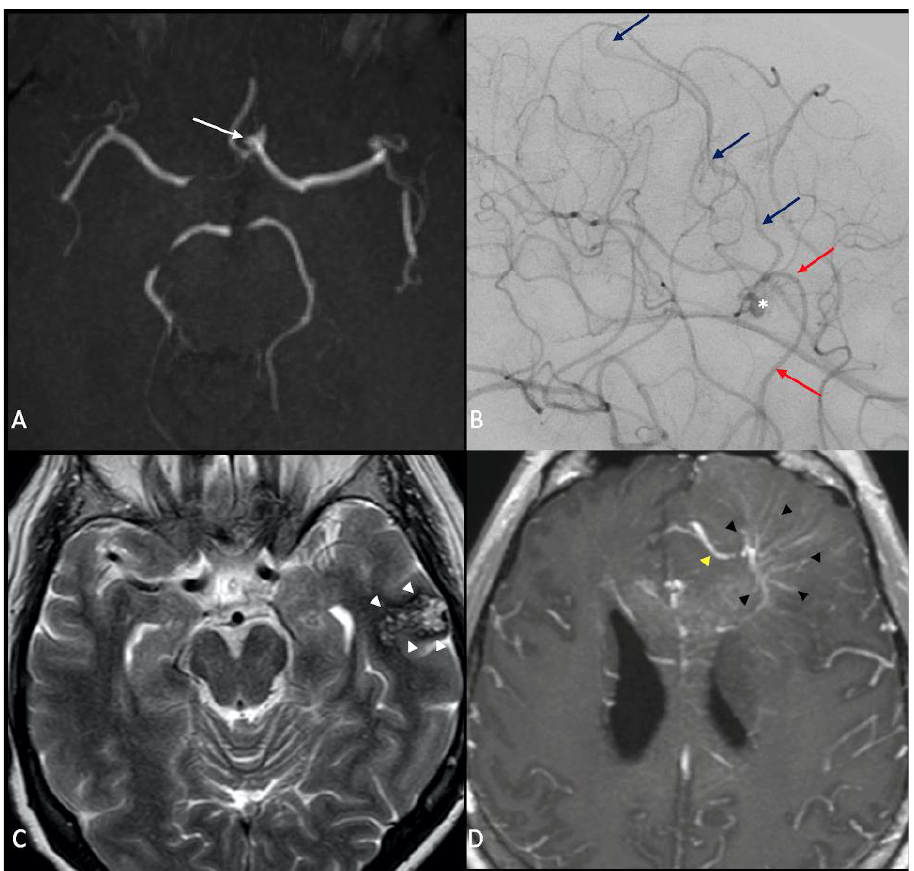
Figure 2. Representative MR images of the cerebrovascular malformations found in our cohort. ( A ) 3D-time of flight MR demonstrating a small anterior communicating artery aneurysm. ( B ) Lateral projection in a Digital Subtraction Angiography during internal carotid artery injection: a small nidus of an arteriovenous malformation (AVM) is evident (white asterisk), as well as an arterial feeder coming from the middle cerebral artery (red arrows) and the draining vein going to the superior sagittal sinus (blue arrows). ( C ) MR T2-weighted axial image shows a large, cavernous angioma (CA) in the cortical region of the left temporal lobe (white arrow heads), with a characteristic “popcorn” appearance and a rim of signal loss due to hemosiderin. ( D ) MR T1-weghted post-contrast axial image showing a vascular malformation characterized by a “caput medusae” (black arrowheads), which is a collection of dilated medullary veins, which converges in an enlarged transcortical or collector vein (yellow arrowhead), which is pathognomonic of developmental venous anomaly (DVA).